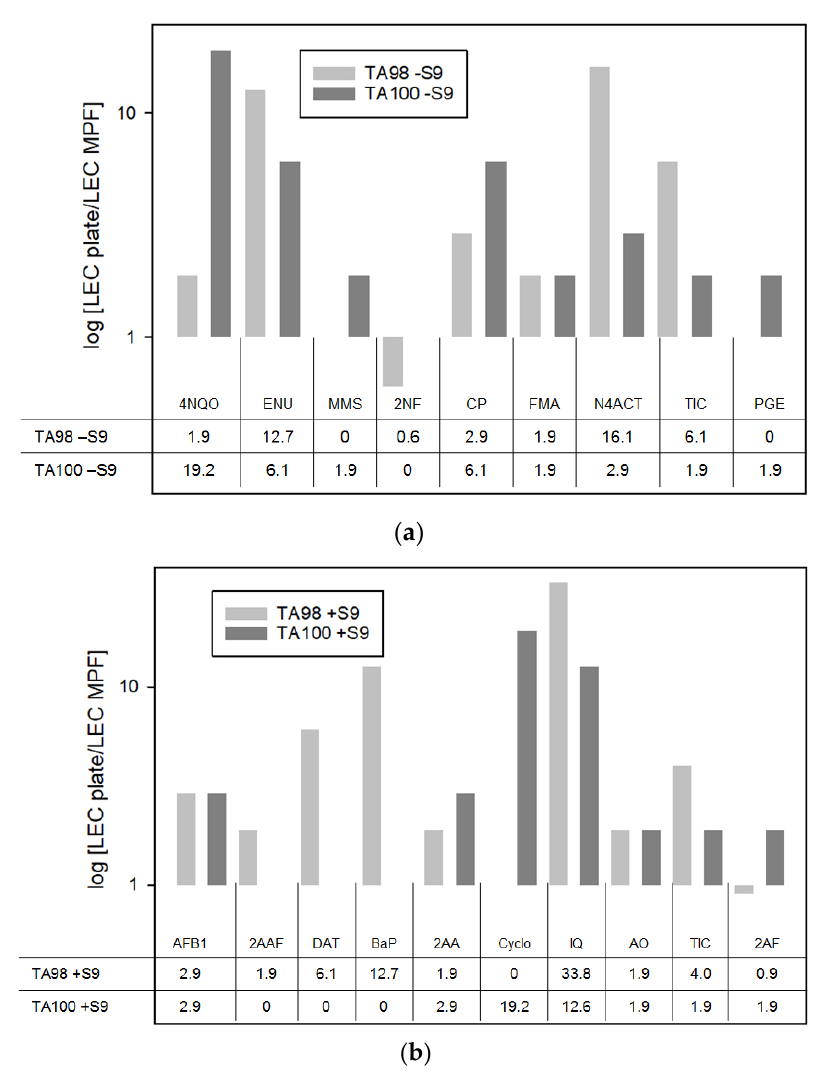
Figure 2. Relative differences in LECs between the Ames MPF and the standard pre-incubation Petri-dish agar-based Ames test are shown in logarithmic scale. The factor was calculated by dividing the mean LEC of the agar-based Ames test by the mean LEC of the Ames MPF. Therefore, a higher factor means a better performance of the Ames MPF assay. ( a ) Test results without metabolic activation, ( b ) results including metabolic activation with PB/ßNP induced S9.